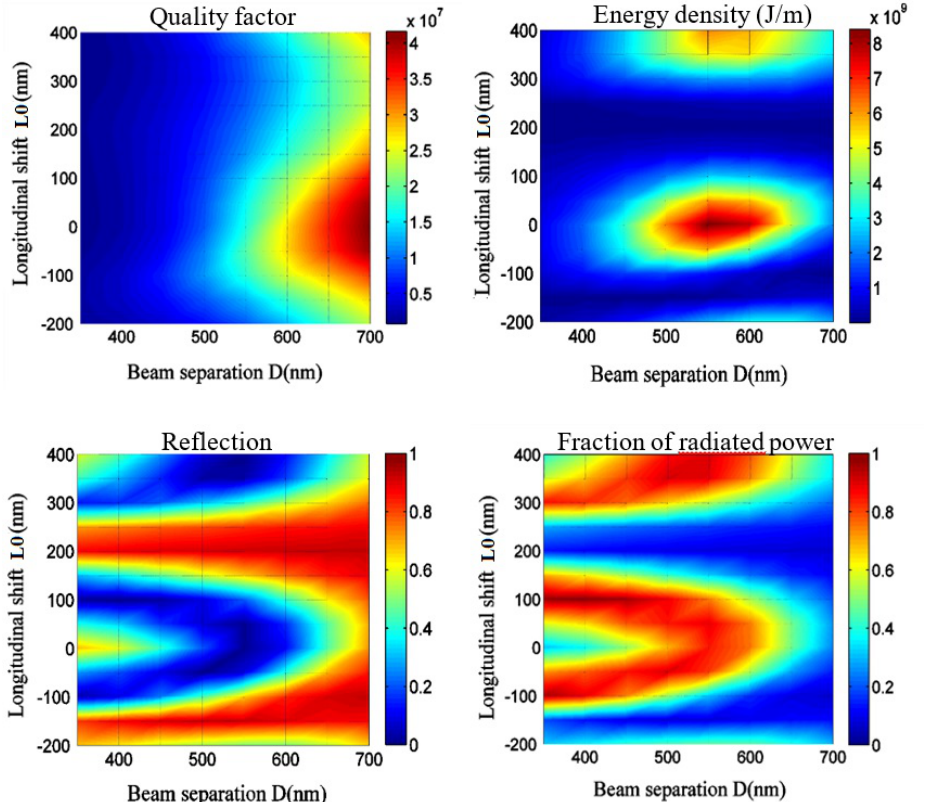
Figure 9. Optimization of D and L 0 for the optical mode at λ = 1550 nm (tapered